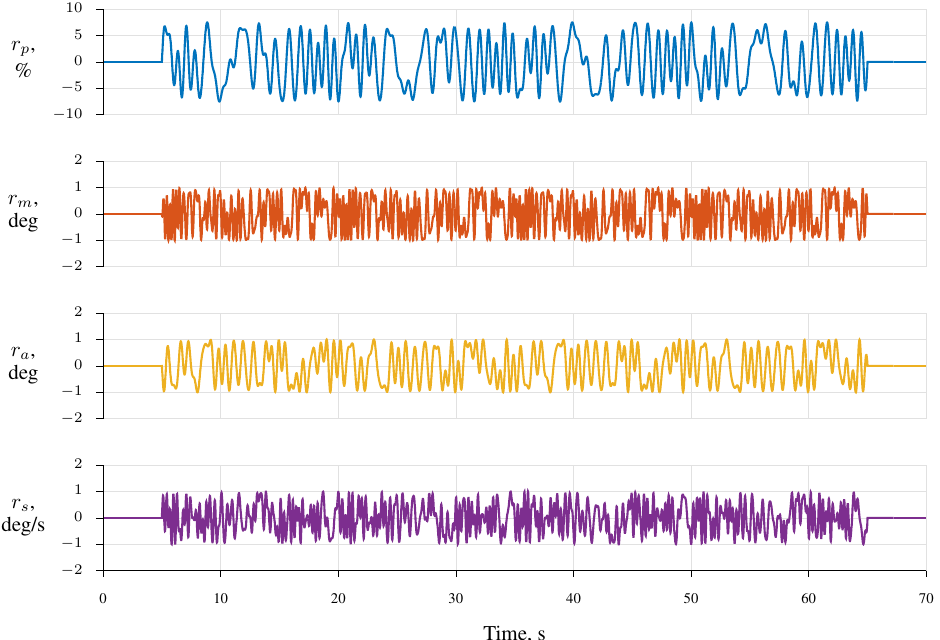
Figure 8. The X-59 multisine time histories. The excitations were applied to the closed-loop simulation and the data were sam- pled at 100 Hz. Measurement noise sequences were added to all sensor measurements. Figures 9 and 10 show the inputs and outputs that were needed to identify the bare- airframe, closed-loop system, and broken-loop frequency responses. These are again color coded to match Figure 1. The only exception is the second output, which was com- mon for all of the frequency responses except for the open-loop stabilator and is shown in black. Evidence of the measurement noise was present in all signals except for u cl . Note that the designed excitations kept the inputs and outputs relatively small in amplitude but with good signal-to-noise ratios, the lowest being 7.6 for the FCS output y mb .